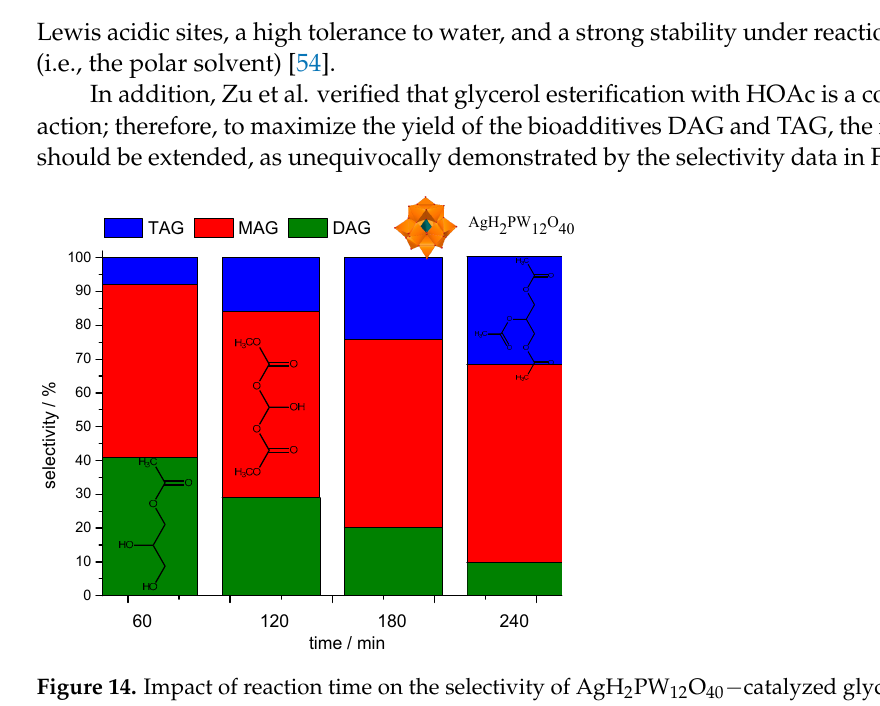
Figure 14. Impact of reaction time on the selectivity of AgH 2 PW 12 O 40 − catalyzed glycerol esterifica- tion with acetic acid. Reaction conditions: temperature (393 K); glycerol/acetic acid molar proportion (1:10); catalyst loading (1 wt.%) (Adapted from ref. [54]).